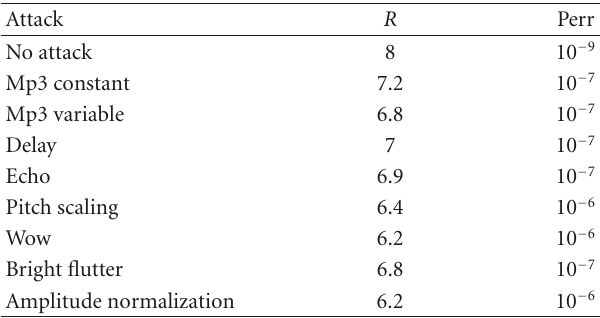
Table 2: The measures of detection quality for the proposed approach under various attacks.